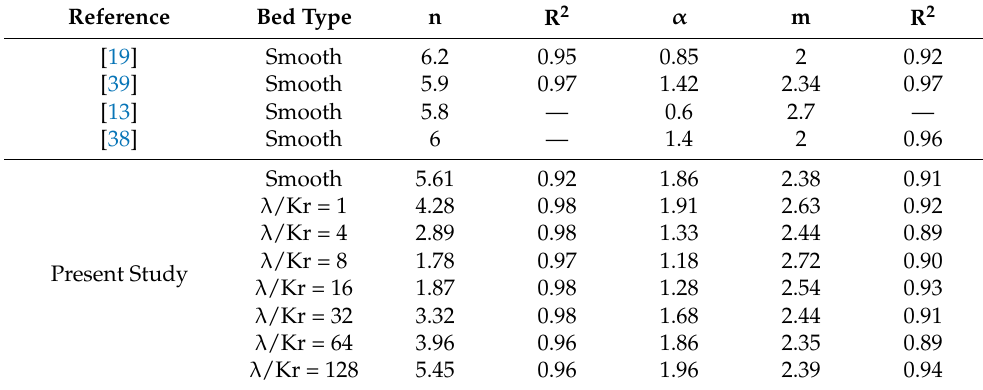
Table 2. Constants obtained for Equations (3) and (4).